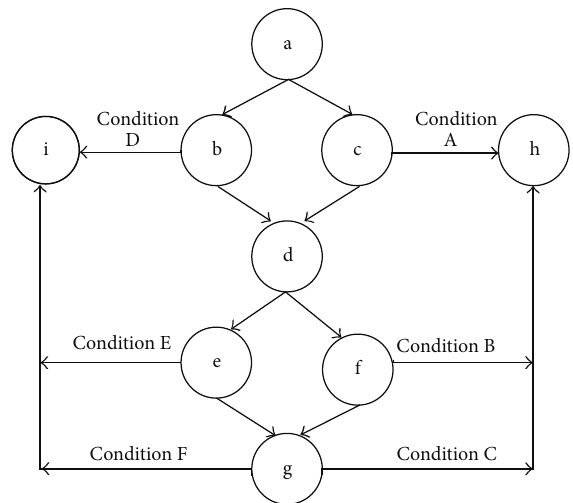
Figure 1: Process control flowchart model 𝐺